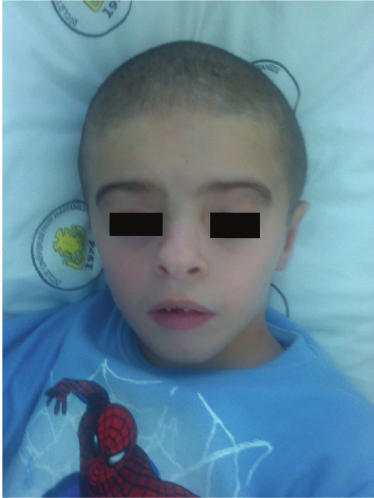
Figure 3: Dysmorphic facial appearance of the patient.